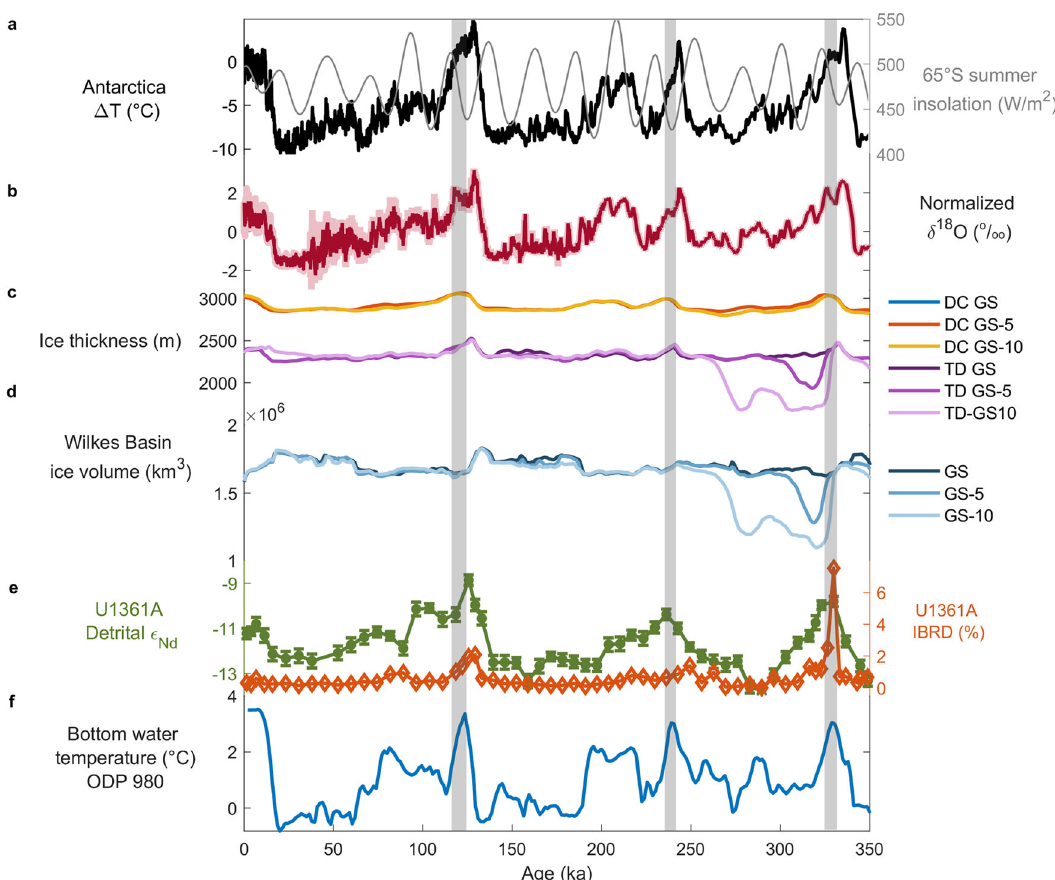
Fig. 3 | Comparison of the Talos Dome ice core (TALDICE) isotopic record to Grenoble Ice Sheet and Land Ice (GRISLI) simulations, sedimentological data from sediment core U1361A, and Antarctic atmospheric and oceanic tem- peraturerecordssince350ka.a Antarctic ice core temperature difference ( Δ T, difference from mean values of the last millennium) derived from δ D at Epica Dome C (EDC) 31 plotted on the Antarctic Ice Core Chronology 2012 (AICC2012) 66 and 65°S summer insolation (grey curve) 70 . b TALDICE normal- ized δ 18 O record (data centred and scaled to have mean 0 and standard deviation 1) (measured, pink; resampled at 200 year intervals, red). Holocene data are from Stenni et al. 34 and Marine Isotopic Stage (MIS) 5.5 data are from Masson-Delmotte et al. 30 . The MIS 7.5 and MIS 9.3 isotopic data are from this